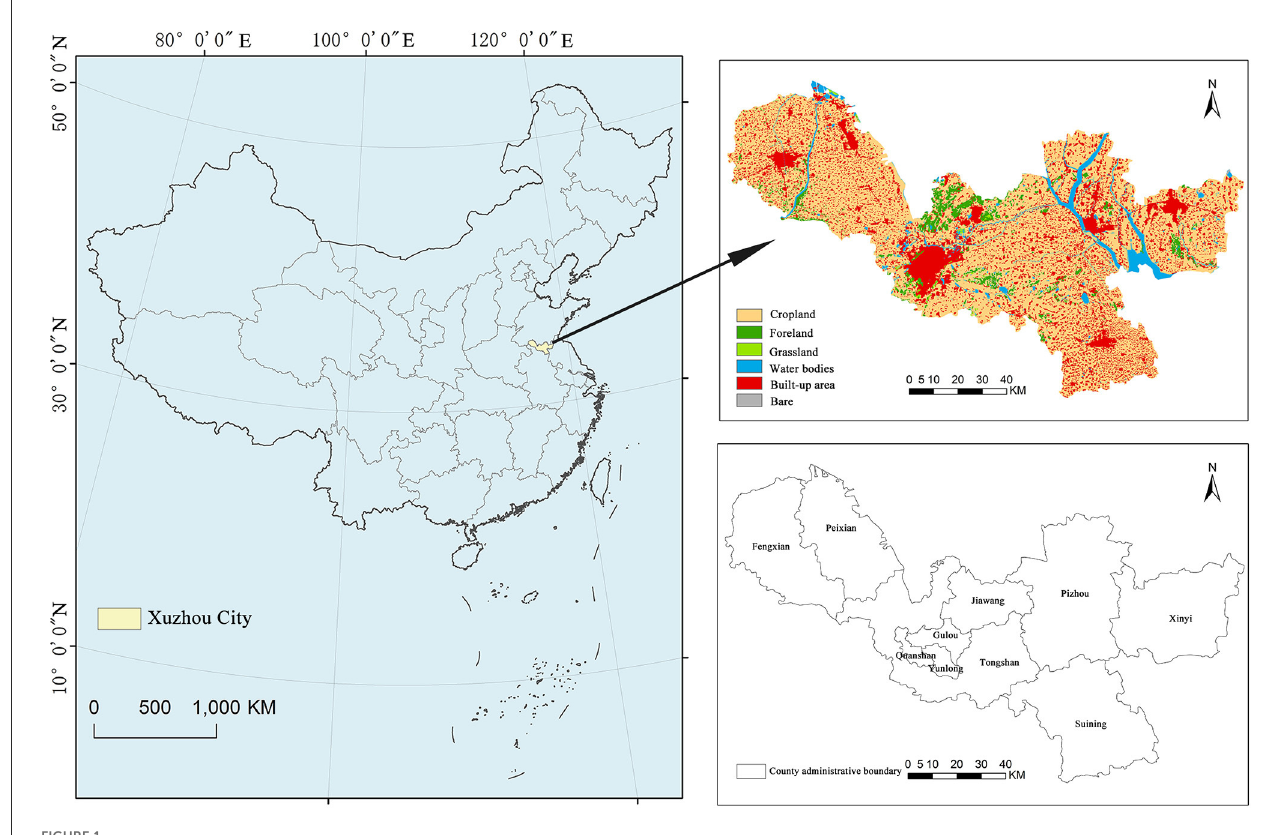
FIGURE1 Geographical location and distribution of land cover types in